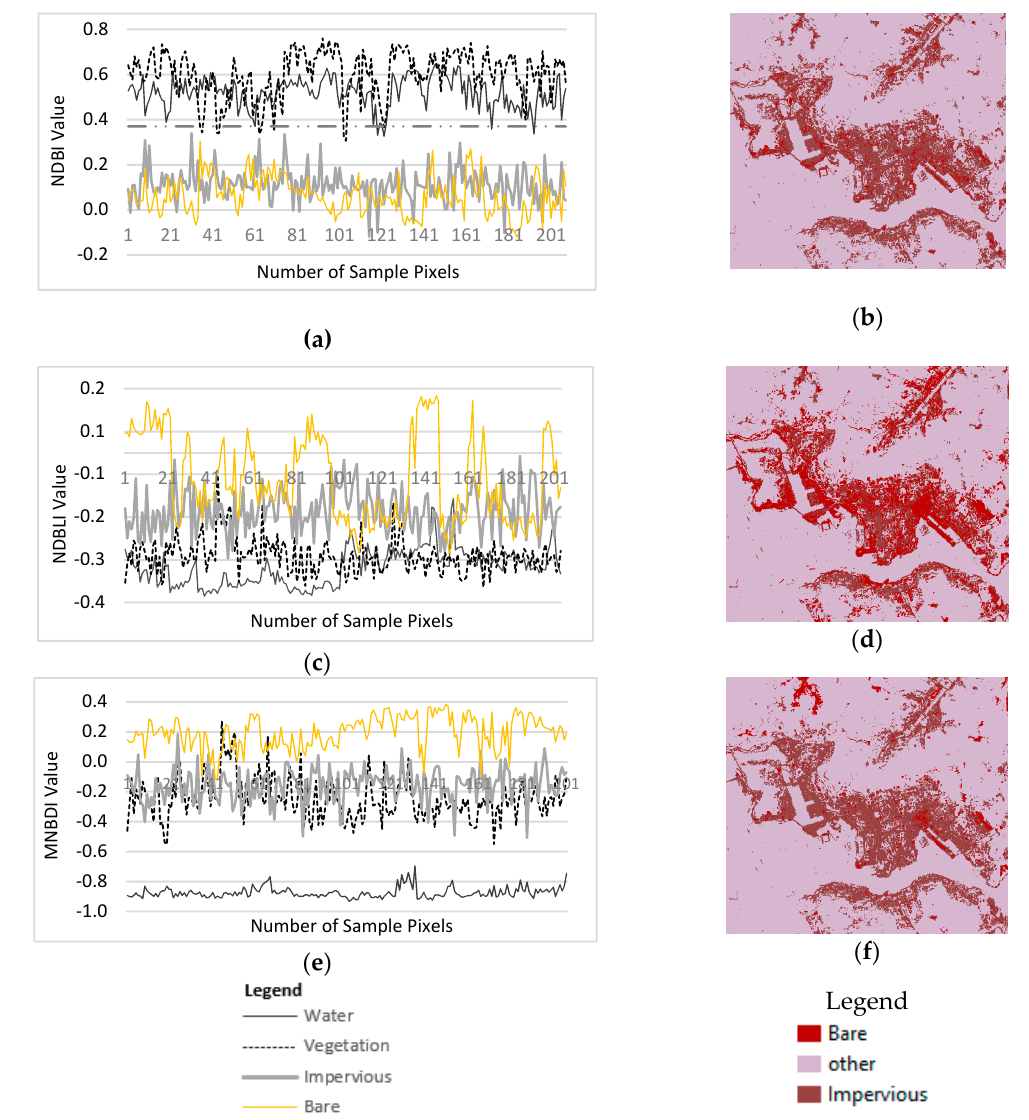
Figure 11. Impervious and bare land separation in Hong Kong using ( a , b ) normalized difference bare-land index (NDBI), ( c , d ) normalized difference bare land index (NDBLI), ( e , f ) MNDBI.